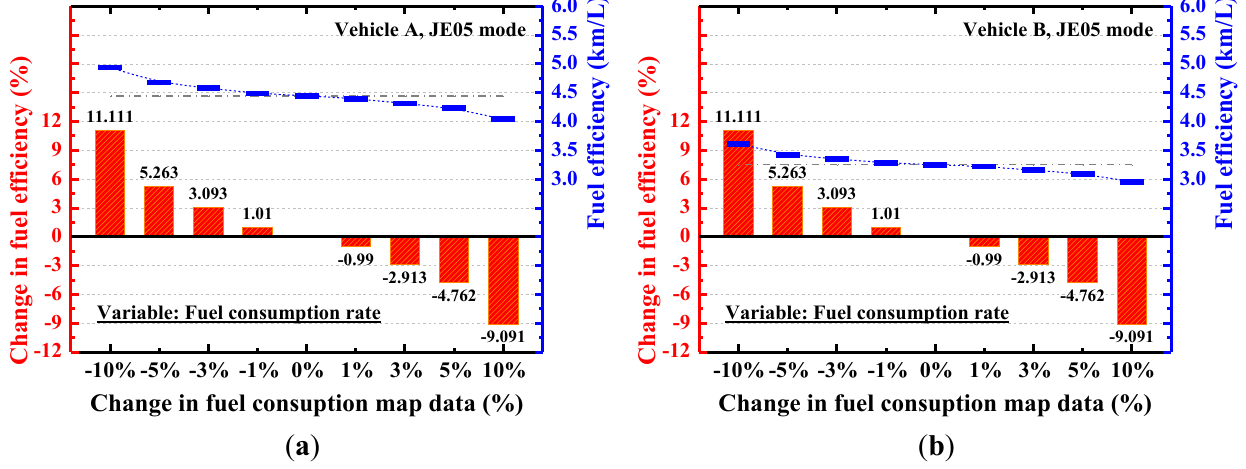
Figure 14. Change of the predicted fuel efficiency results with variation of the